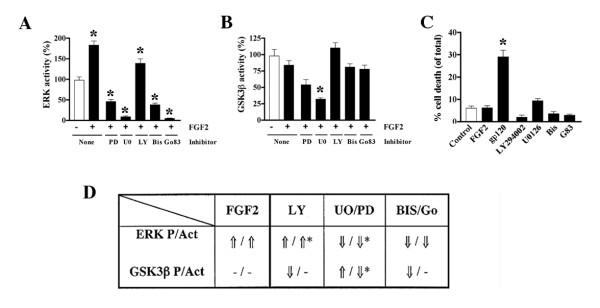
Effects of inhibitors on FGF2-stimulated ERK and GSK3β activity Immunocomplex kinase assays for (A) ERK and (B) GSK3β activity without FGF2 treatment, or after inhibition with PD98059, U0126, LY29004, Bisindolymaleimide I or Gö6983 followed by FGF2 treatment. (C) Inhibitor treatment alone. (D) Summary of changes in phosphorylation (P) versus changes in activity (Act) of ERK and GSK3β. ⇑ Indicates an increase, ⇓ indicates a decrease, – indicates no change. * = P < 0.05 by One-Way ANOVA with post-hoc Dunnett's when compared to control.